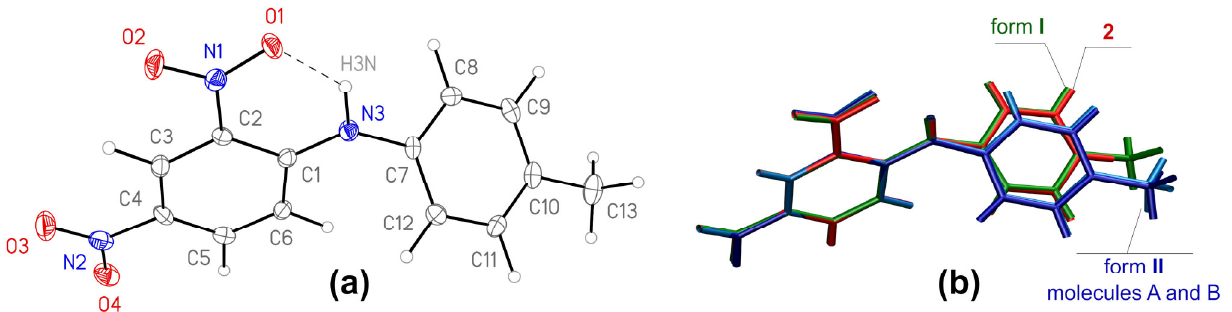
Figure 1. ( a ): General view of the molecule 1 in crystal form I , anisotropic displacement parameters are drawn at 50% probability level; ( b ): overlay of molecules from crystal structures of forms I (green), II (light and dark blue) and crystal structure of 2,4-dinitrodiphenylamine 2 [17],